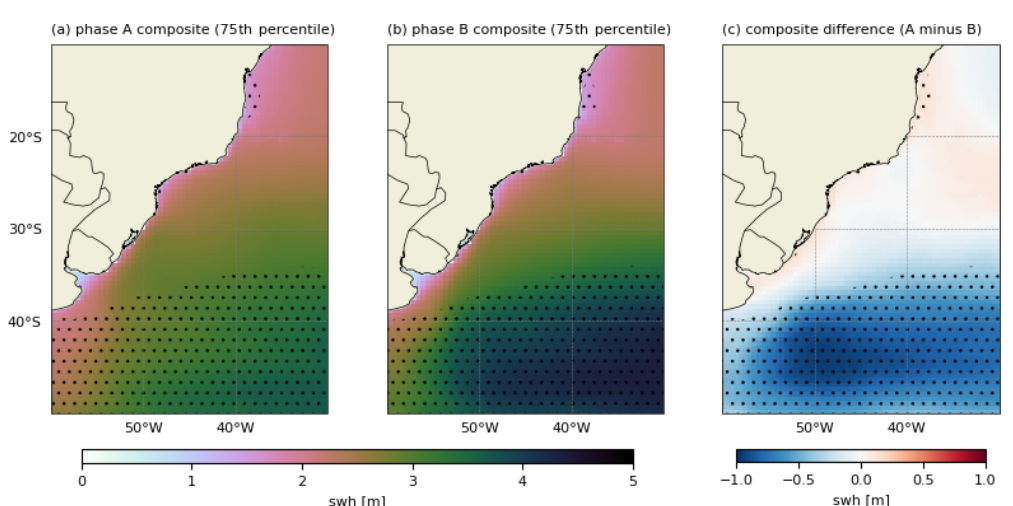
Figure 7. Composites (75th percentile) of swh calculated using phases (a) A and (b) B of the EOF1 of u 10 and (c) difference between the composites. The black dots represent the areas where the difference between phases is within a 95% confidence level.